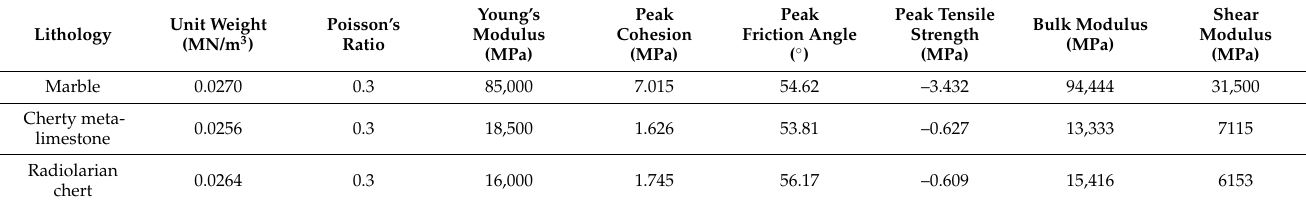
Table 2. Engineering–geological characteristics of rock